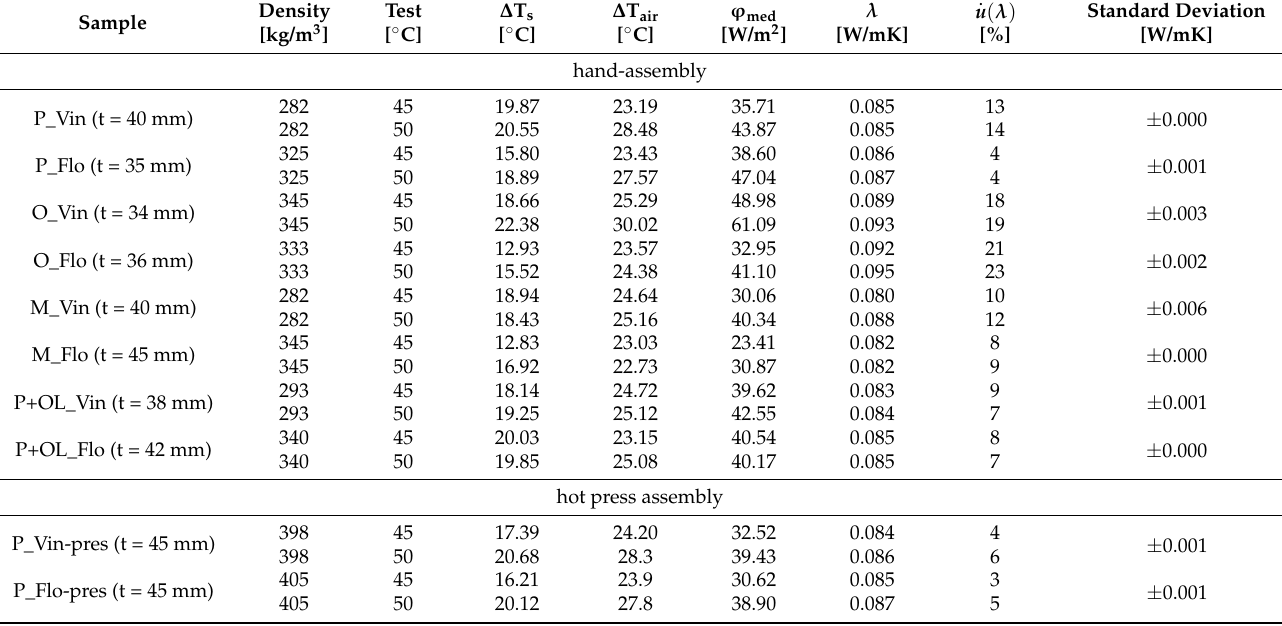
Table 2. Thermal properties of eco-sustainable panels (Small Hot Box—thermal flux meter method).